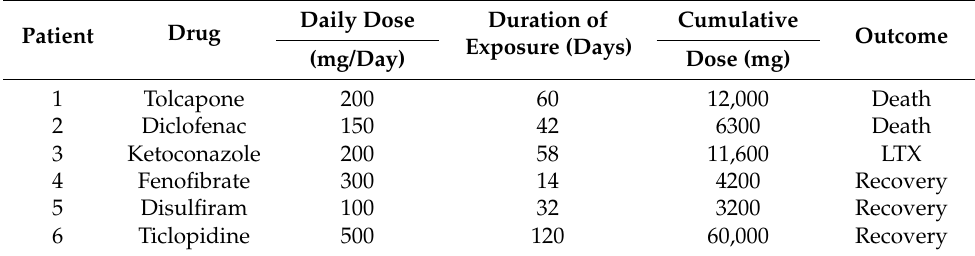
Table 6. Role of cumulative doses of drugs implicated in causing iDILI. Results were calculated from data presented in an earlier study (37). Clinical presentation was acute liver failure in patients 1–3, acute hepatitis in patient 4, acute hepatitis and jaundice in patient 5 and acute cholestatic hepatitis in patient 6. All patients were treated with a multidrug regime, consisting of up to 6 additional drugs. Abbreviation: LTX, Liver